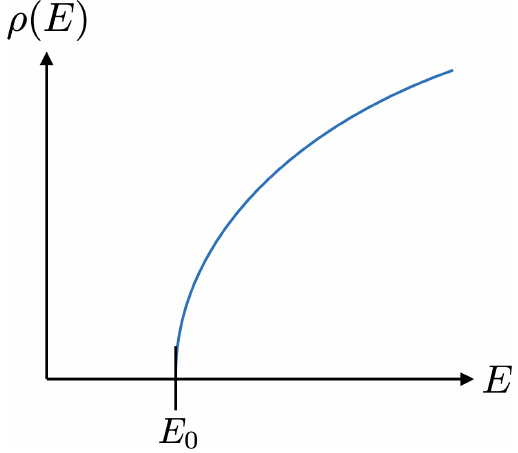
Figure 2 . Depiction of a double-scaled density of